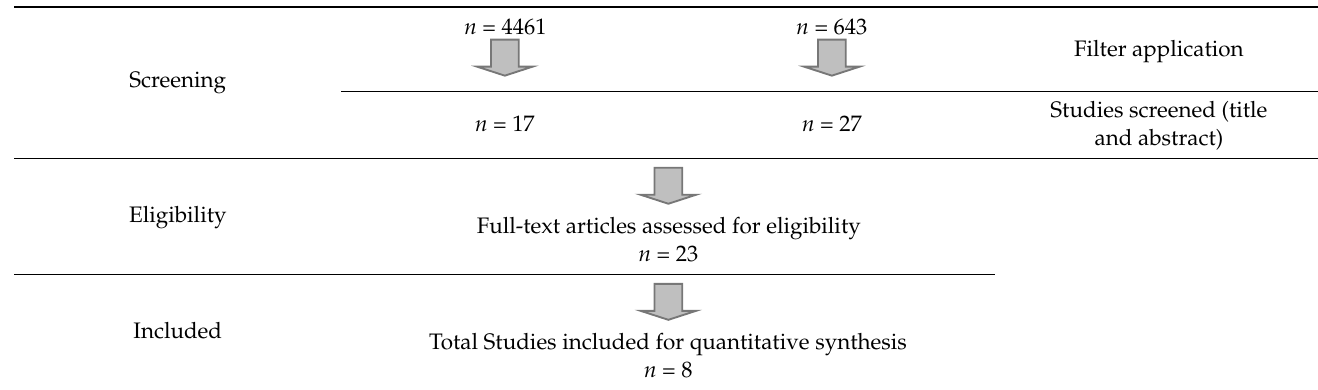
Table 3. Inclusion and exclusion criteria list.